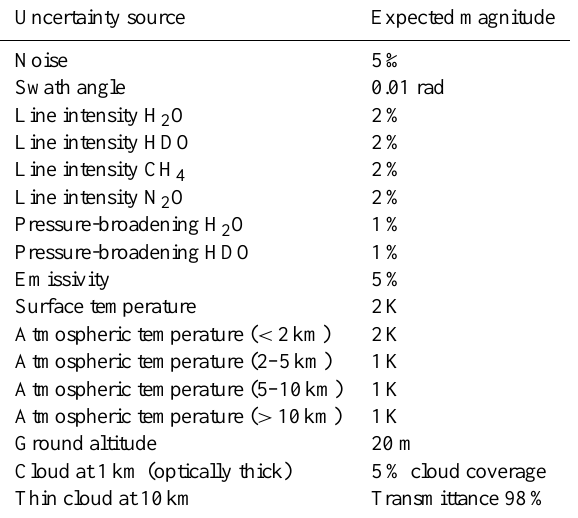
there are independent H 2 O measurements available, we can simulate this error by means of the averaging kernel (bottom left graphs of each group in Fig. 4) and eventually correct it. Please note that this error is even larger, if we do not apply the aposteriori correction. Furthermore, measurement noise 470 and thin elevated clouds are important and can sum up to a random error of 15-25‰. The systematic errors due to the assumed spectroscopic line parameter uncertainties are about 1-2% for H 2 O and 15- 20‰ for δ D. Further systematic errors might occur in case 475 of frequently not identified thin elevated clouds.